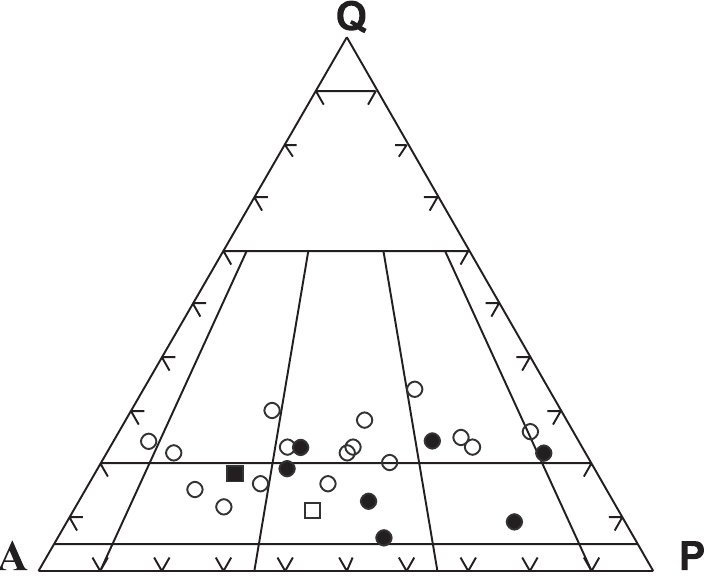
Fig. 4 – QAP modal diagram (Streckeisen 1976) for gneissic rocks, granitoids, granitic leuco- somes and Passa Tempo Metamorphic Complex felsic mobilizates (gneisses: open circles; felsic mobilizates: filled circles; dated mesosome: open square; dated leucosome: filled